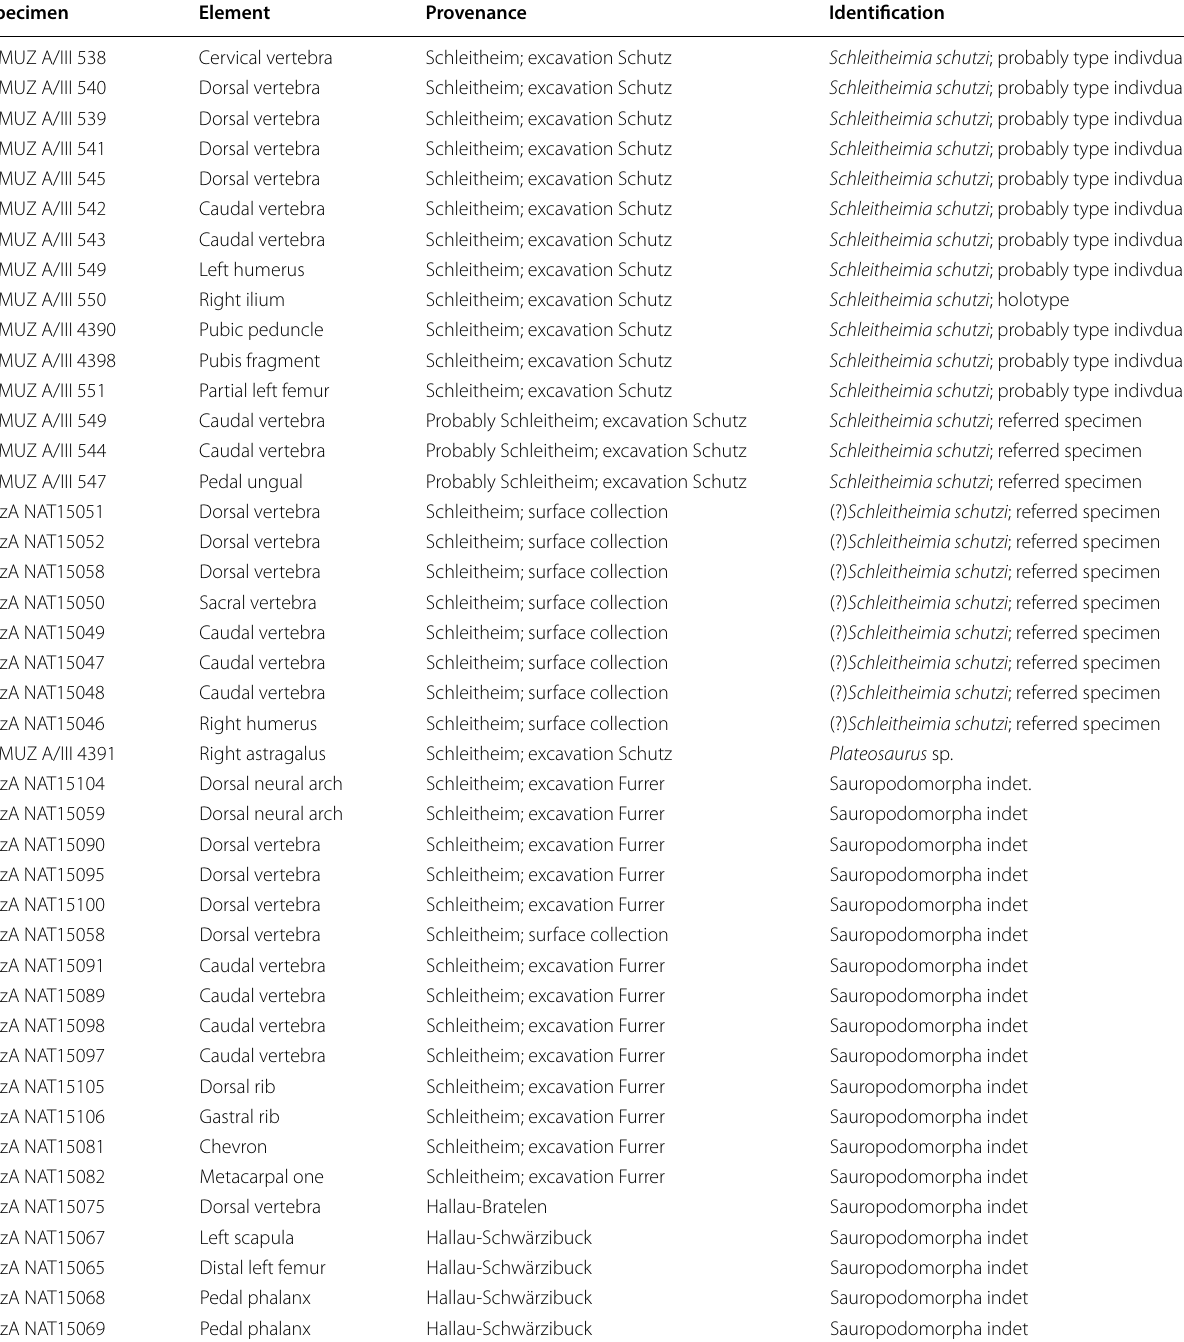
Table 1 List of materials detailing provenance and identification proposed here